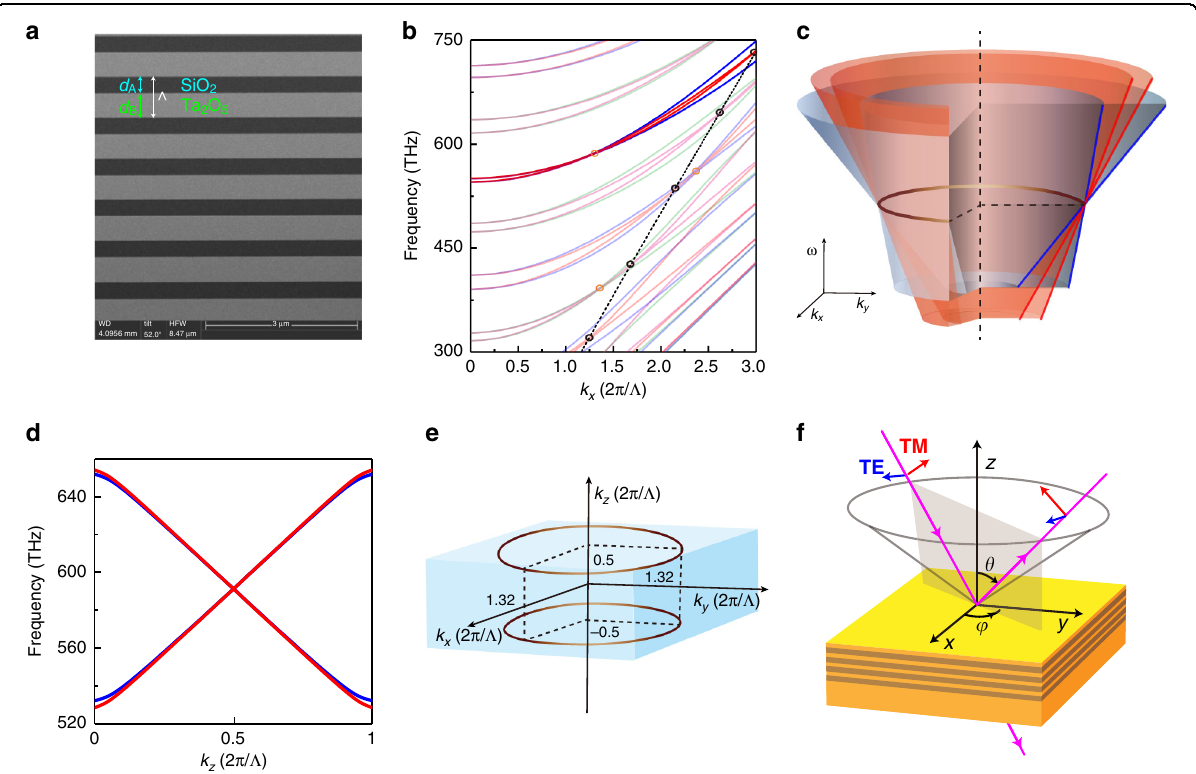
Fig. 1 Photonic DNLS. a SEM image of the PC. b Dispersion along the k x direction at k z ¼ 0 (green and magenta) and k z ¼ π = Λ (red and blue). The blue and magenta lines represent TE polarization, and the red and green lines represent the TM polarization. The bands forming the DNR, which is the focus in our study, are highlighted, while the other bands are partially transparent. The dashed line indicates the locus of the Brewster angles, where the TM gaps close. The gap closing points for both polarizations (at the Brewster angles) are encircled in orange (black). c Sketch of the in- plane dispersion around the DNR (golden). The DNR is four-fold degenerate, consisting of two sets of type-II Weyl nodal rings of TE (blue) and TM (red) polarizations. d Dispersions along the k z direction around the four-fold degeneracy point for TE (blue) and TM (red) polarizations. e The position of the DNR in the reciprocal space. f The experimental setup. We employ SiO 2 (Ta 2 O 5 ) for layer A (B), with a thickness of d A = 388 nm ( d B = 597 nm). The refractive index of the SiO 2 (Ta 2 O 5 ) is around 1.48 (2.25) with slight dispersion in the visible regime (see Supplementary Data